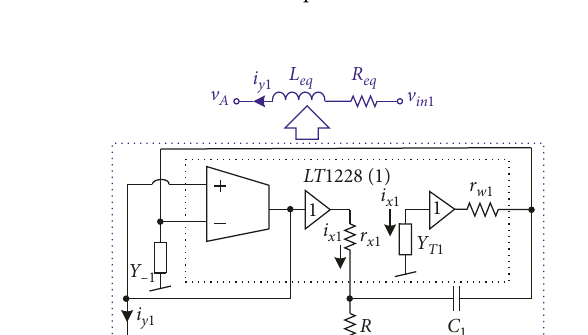
Figure 4: LT1228 parasitic elements.